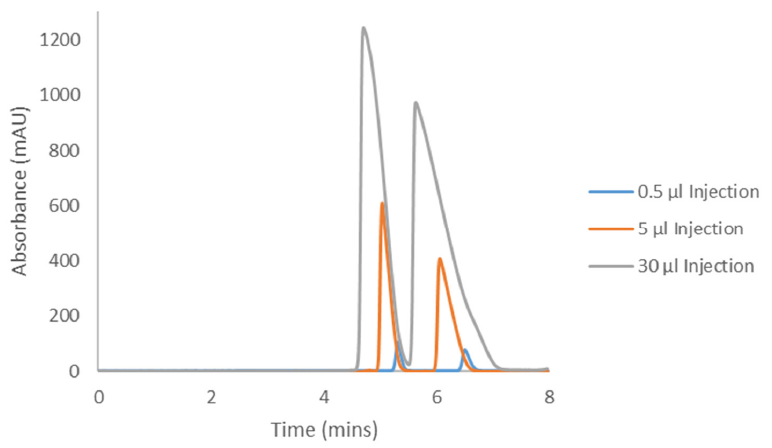
Figure 6. Preparative loading of CBCA with a sample concentration of 25.0 mg/mL on CHIRALPAK ® IK with Hex − DCM − TFA = 80 − 20 − 0.1.